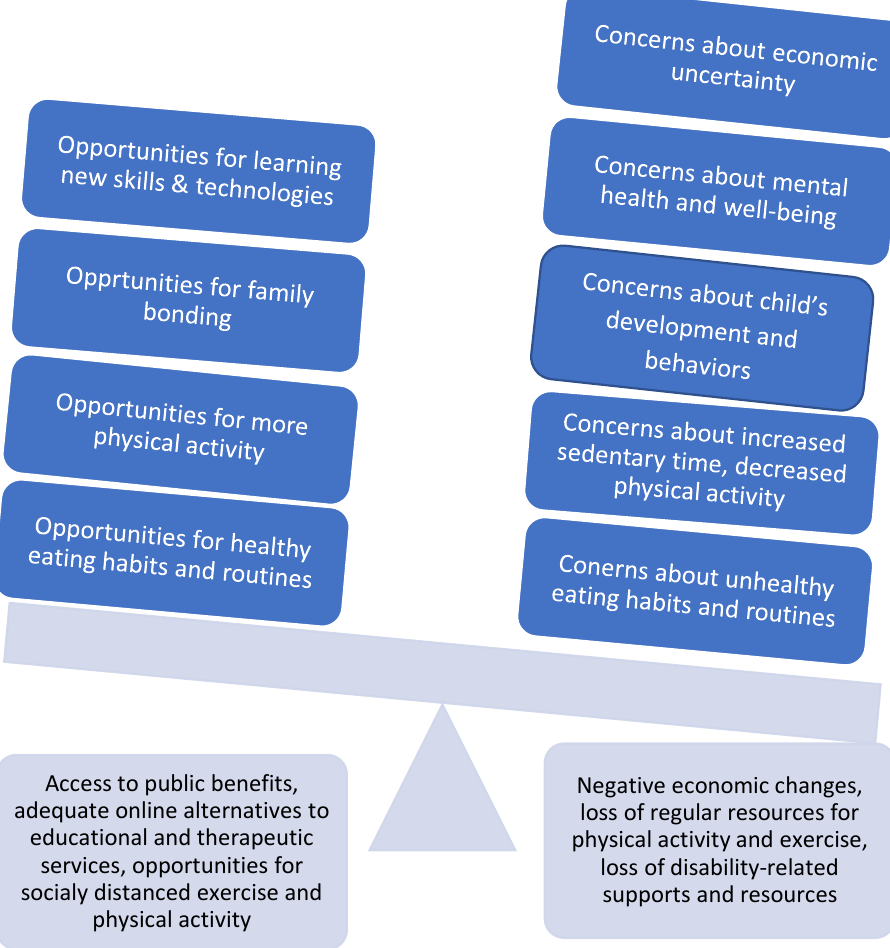
Figure 1. Themes and the dynamic relationship between